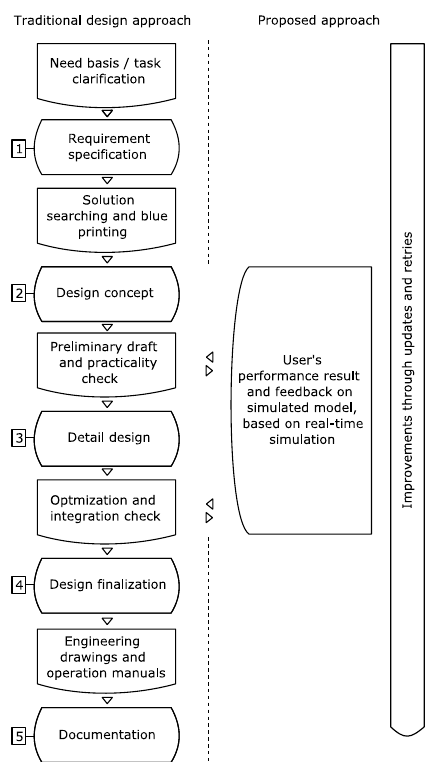
Figure 1. Focus of the proposed approach in relation to the traditional design approach in the VDI 2221 guideline